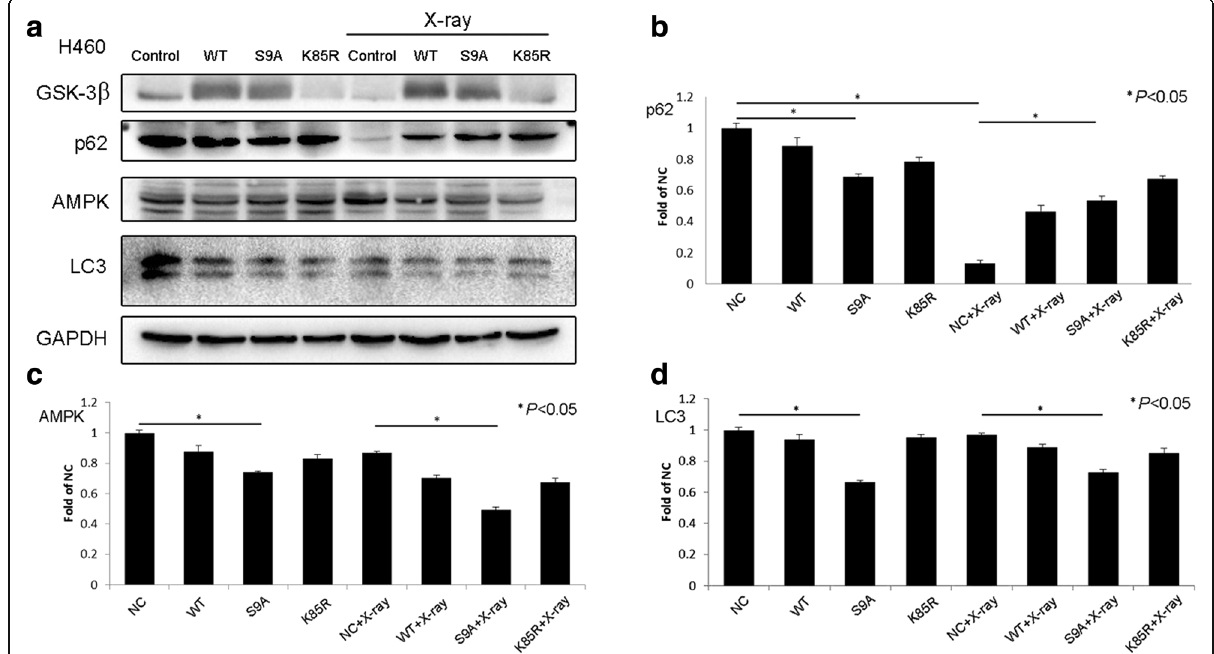
Fig. 4 GSK-3 β inhibited cellular autophagy. Western blotting showed that ( a ) after X-ray irradiation alone, GSK-3 β and p62 levels decreased, whereas AMPK and LC3 levels did not change significantly in H460 cells. After transfection with GSK-3 β with different activity levels, p62, AMPK, and LC3 levels decreased. After transfection with GSK-3 β with different activity levels and X-ray irradiation, p62 levels increased, whereas AMPK and LC3 levels decreased. These changes were more significant for transfection with the active GSK-3 β -S9A mutant than for transfection with the GSK-3 β -WT or inactivated GSK-3 β -K85R mutant ( b , c , d ). * P <